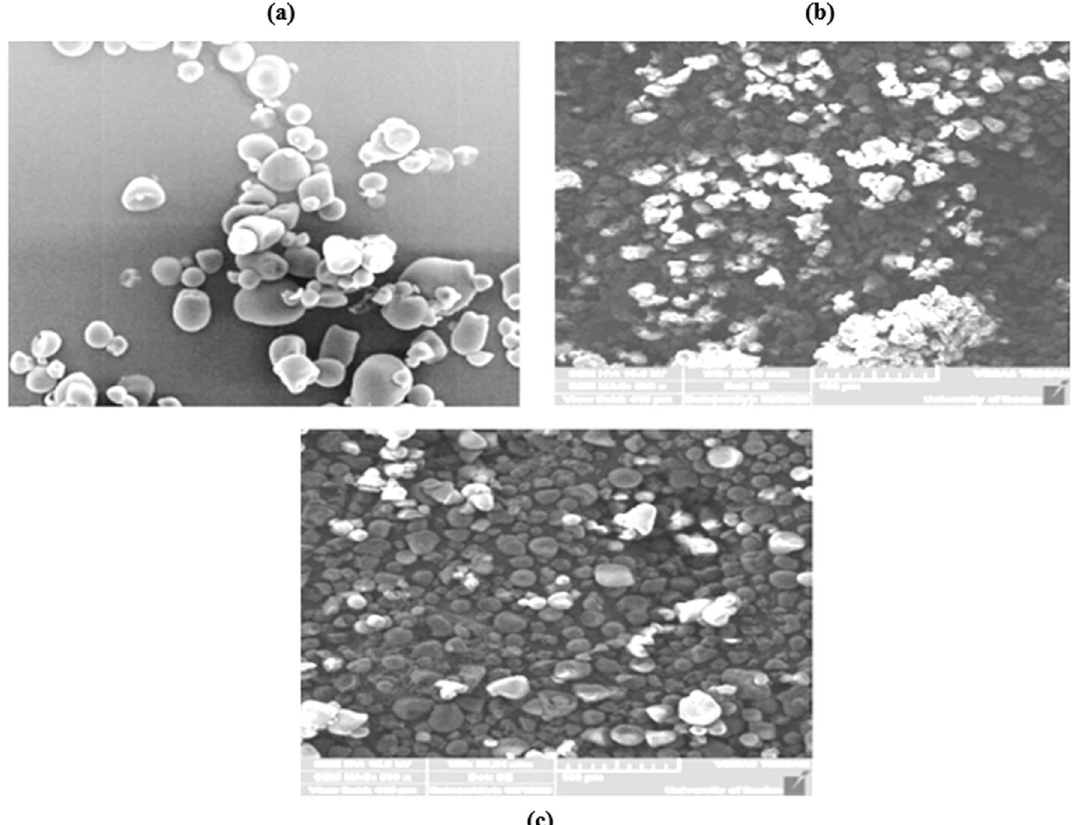
Fig. 1 SEM micrographs of a untreated potato starch, b chemically treated potato starch-6 days, and c mechanically treated potato starch-6